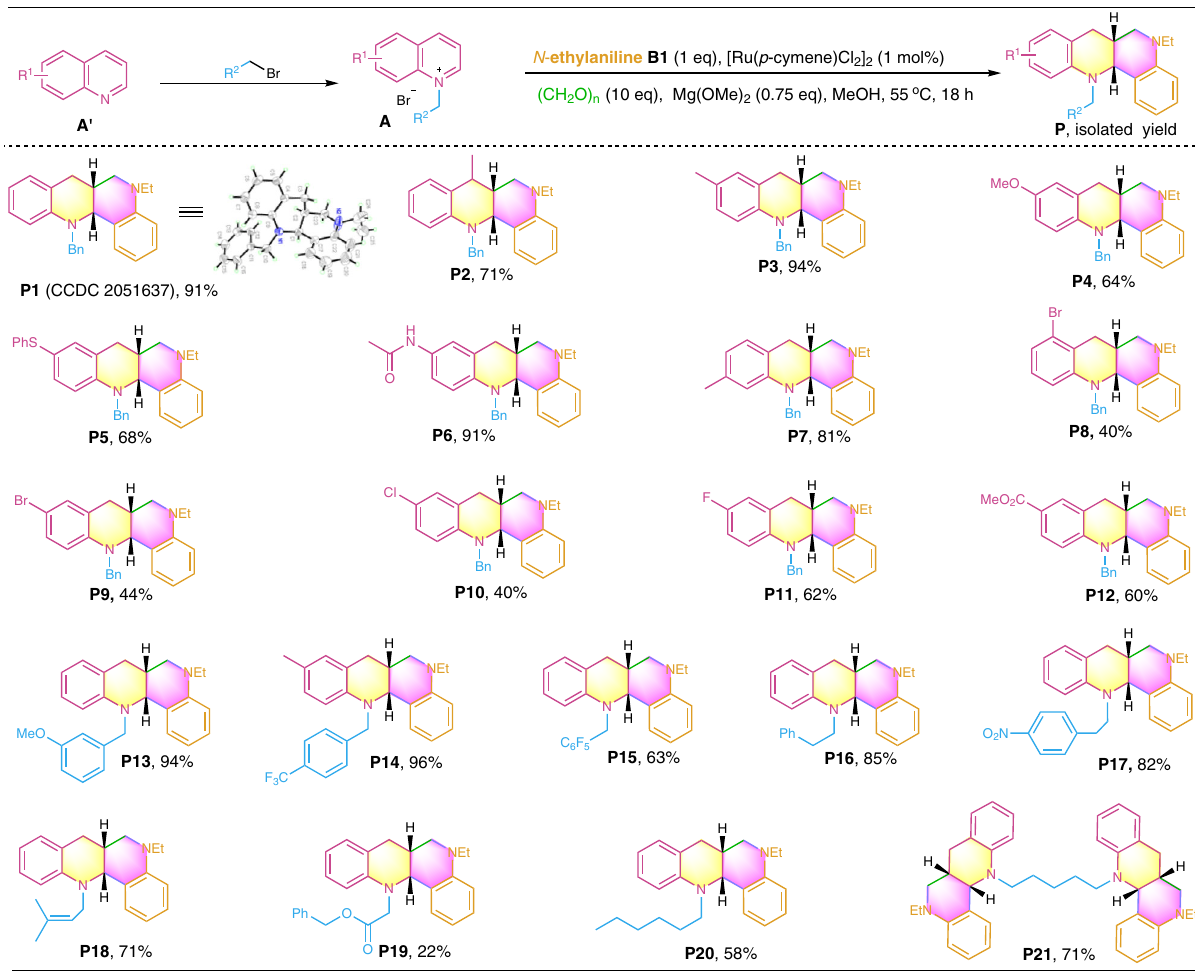
Fig. 2 Diastereoselective construction of fused N-heterocycles P1 − P21 by variation of quinolines. Reactions were conducted on a 0.2 mmol scale under the standard conditions. Isolated yields are